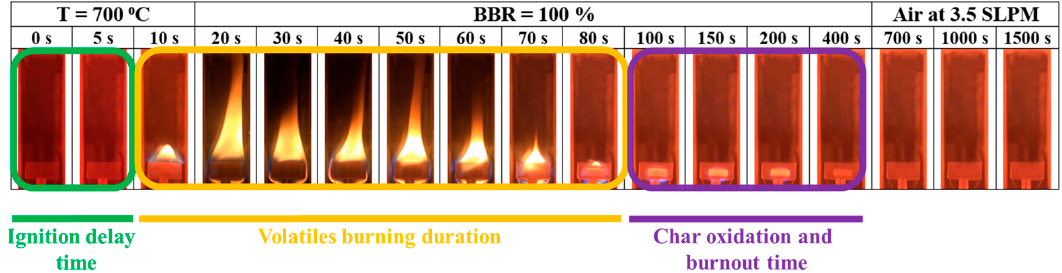
Figure 15. Graphic of stages in pure sewage sludge pellet combustion process.